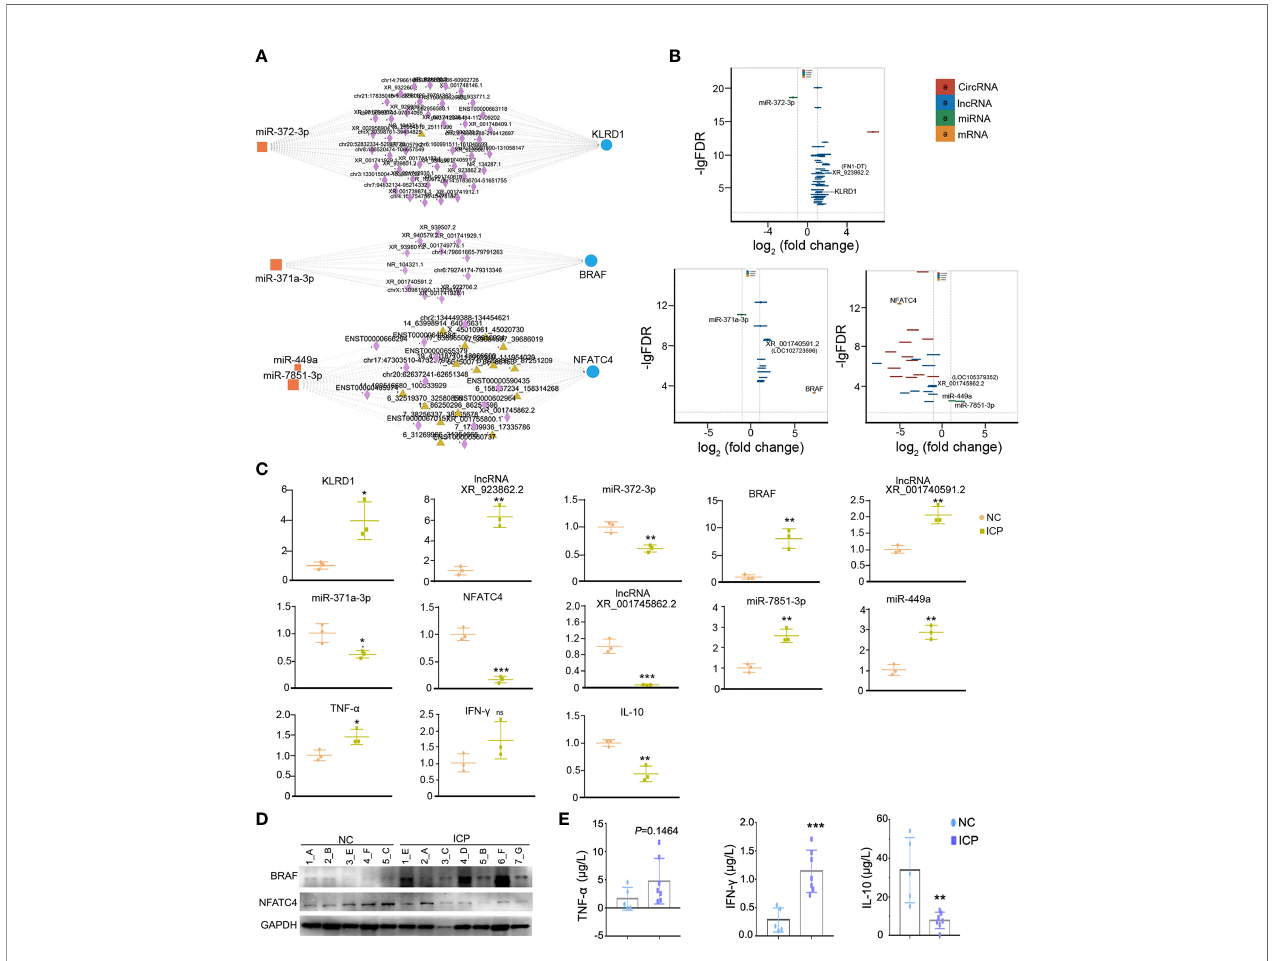
FIGURE 5 | The validation of obviously differentially expressed RNAs in the ceRNA network. (A) The ceRNA network of KLRD1, BRAF, and NFATC4 (rectangles, DEmiRNAs; triangles, DEcircRNAs; diamonds, DElncRNAs; Circles, DEmRNAs). (B) The fold changes of KLRD1, BRAF, and NFATC4 were involved in ceRNA regulatory network in the ICP group compared with the control group. (C) The validation on RNA expression in the ICP group (n=3) compared with the control group (n=3) by qRT-PCR. Each dot represents the average value of one sample in three experimental replicates. (D) The protein level of NFATC4 and BRAF in the ICP group compared with the control group. The letters represented the different placenta tissues. (E) Comparison of cytokines levels in placenta tissue between ICP and healthy controls. Cytokines concentrations of TNF- a , IFN- g and IL-10 were compared between ICP patients (n=7) and healthy controls (n=5). Data were shown as mean ± SD. Differences were analyzed by unpaired t test. All P-values are two-tailed and signi fi cantly different when P -value is <0.05. * P <0.05, ** P <0.01, *** P